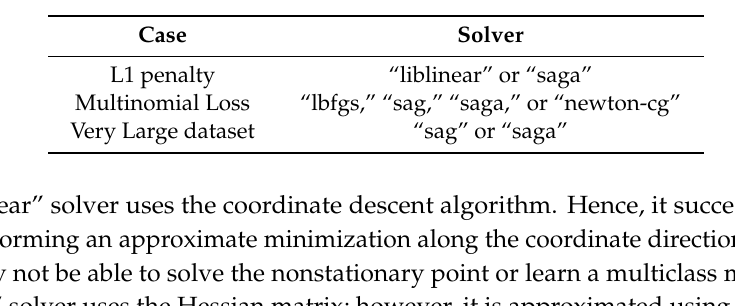
Figure 9. Pass/fail class with linear regression ( a ) and logistic regression ( b ). Figure 9. Pass / fail class with linear regression ( a ) and logistic regression ( b ). Table 3. Appropriate solvers for each case.